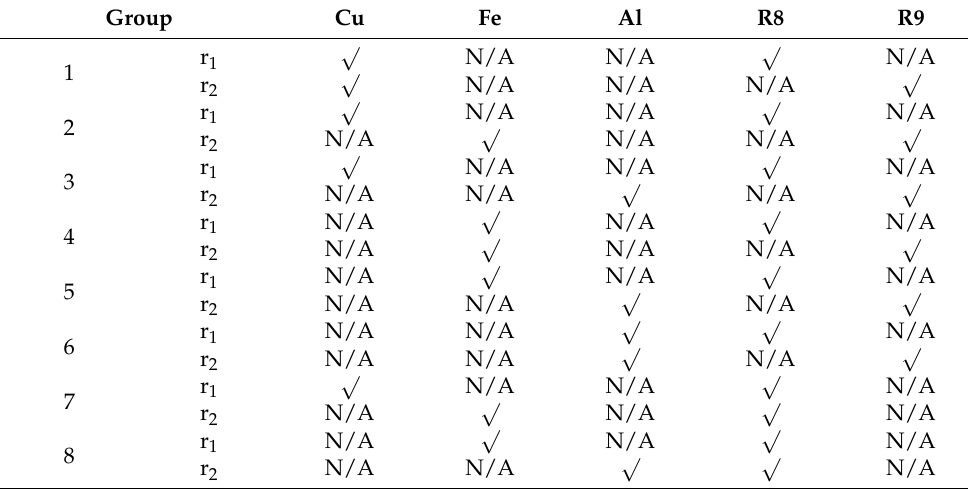
Table 1. The group deviation of the experiment schedule.